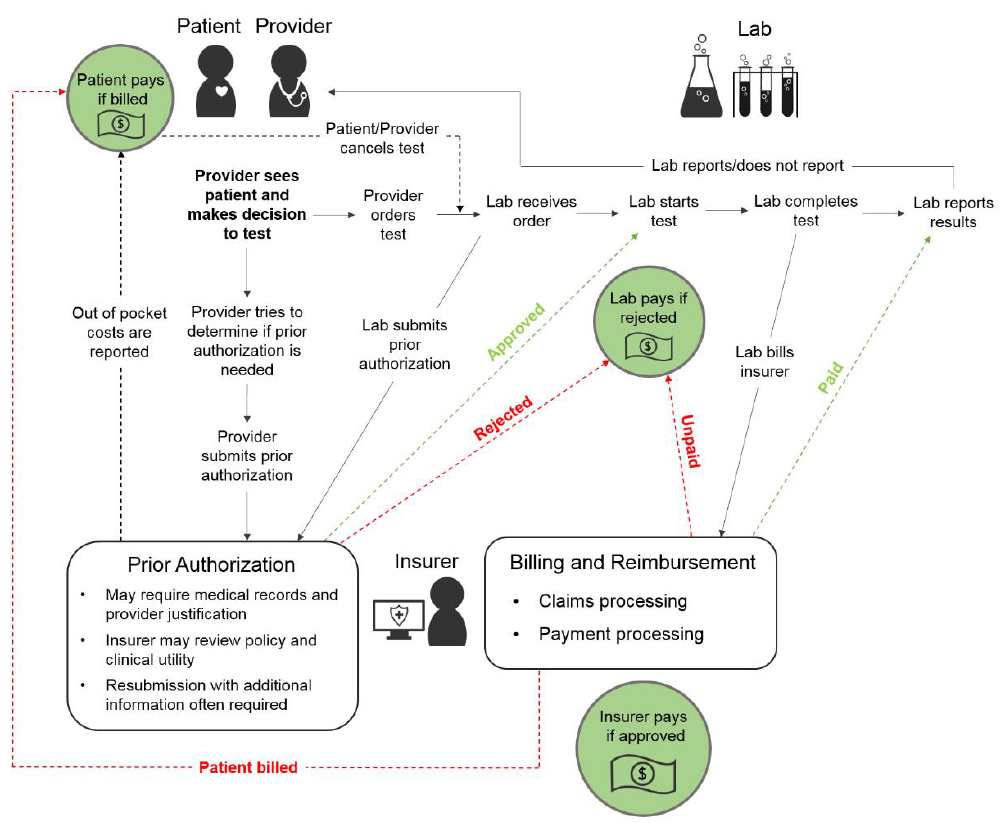
Figure 1. Schematic of the clinical implementation process for pharmacogenomic tests.